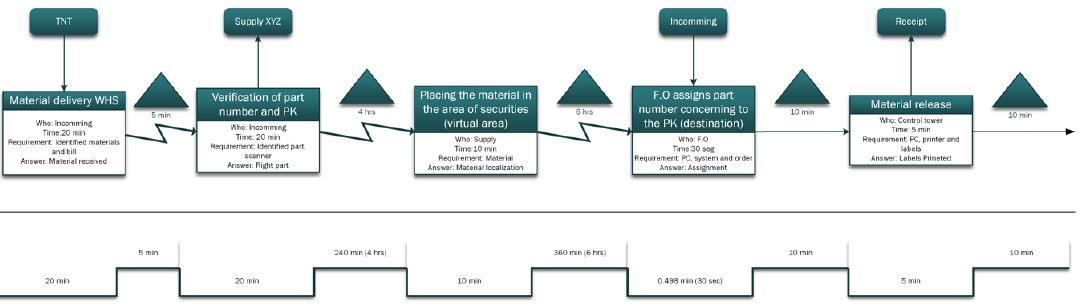
Figure 4. The second part of seven of the Current VSM is displayed.